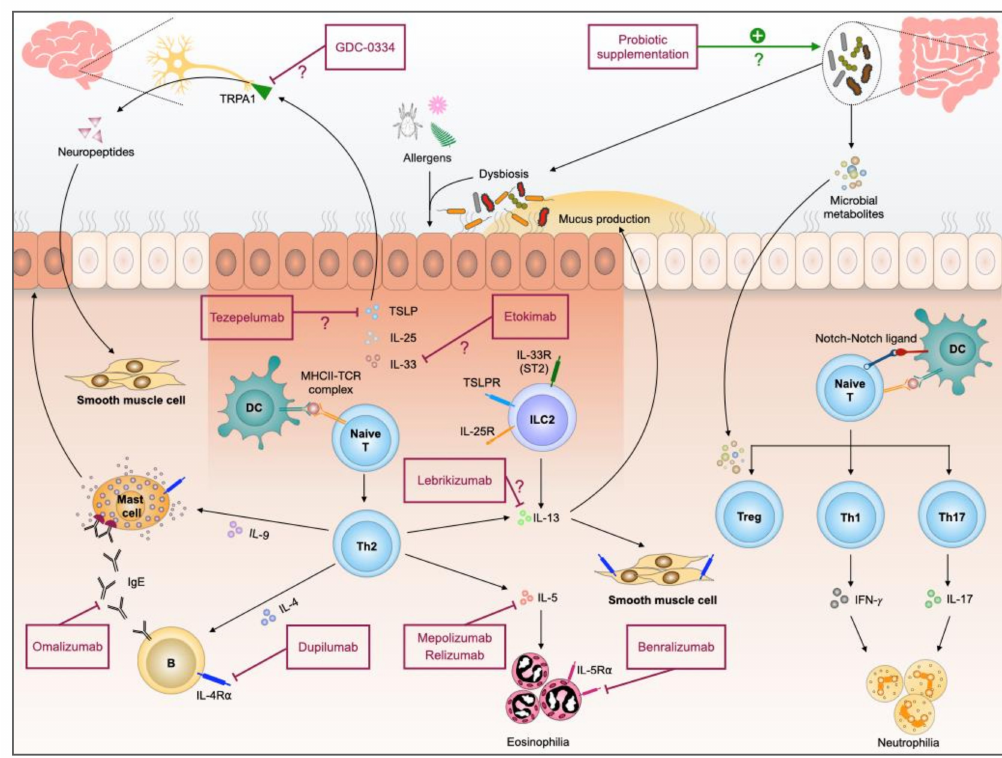
Figure 1. Pathogenesis of allergic airway inflammation and therapeutic interventions currently available and those with